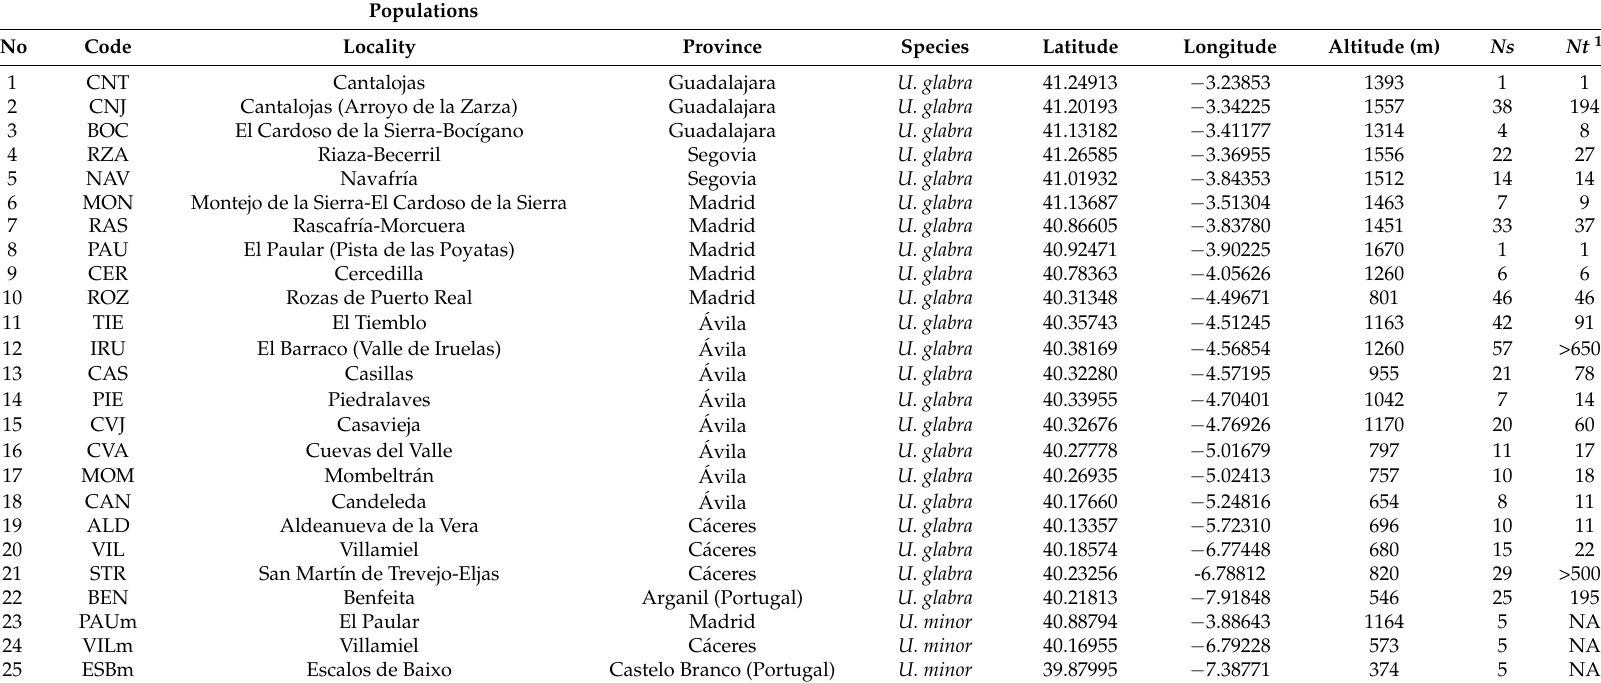
Table 1. Location, number of sampled individuals ( Ns ) and estimated total number of individuals ( Nt ) of Ulmus glabra and U. minor populations studied along the Central System of the Iberian